Question: State the chart type depicted above.
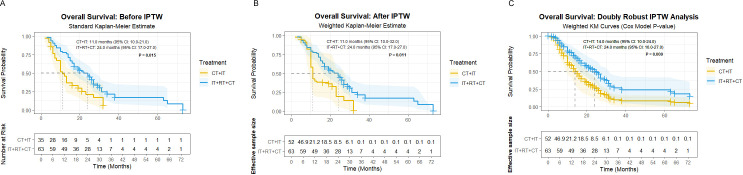
Answer: survival